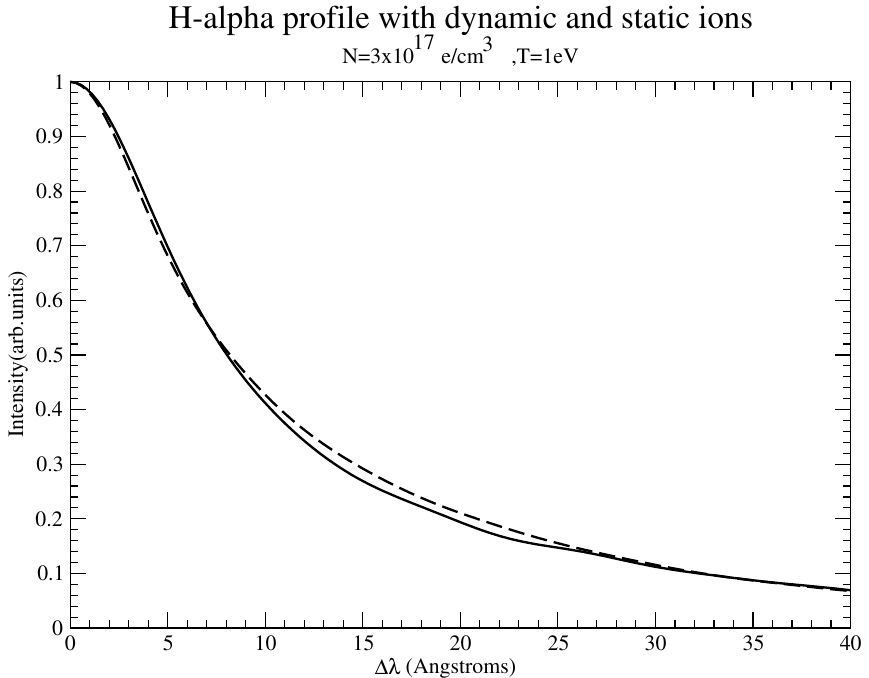
Figure 2. H α profile with dynamic (solid) and static (dashed) ions (protons) for a temperature T = 1 eV and electron density N = 3 × 10 17 e/cm 3 . The dynamic profile is computed by a joint electron-ion simulation, while the static ion profile is computed by convolution of the dynamic (simulation) electron profile with the quastistatic ion